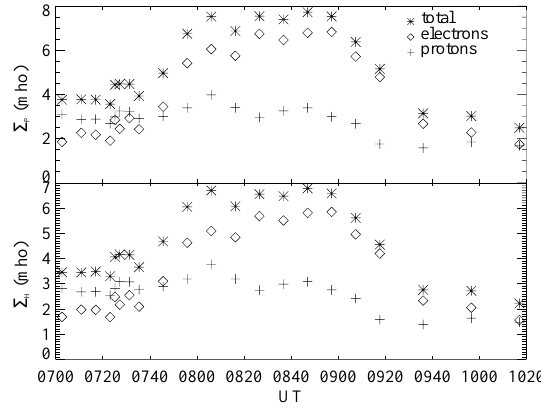
Fig. 6. Time evolution of the Pedersen (top panel) and Hall (bot- tom panel) conductances during a substorm which occurred on 27 November 2000. The conductances are averaged over all the auroral region.